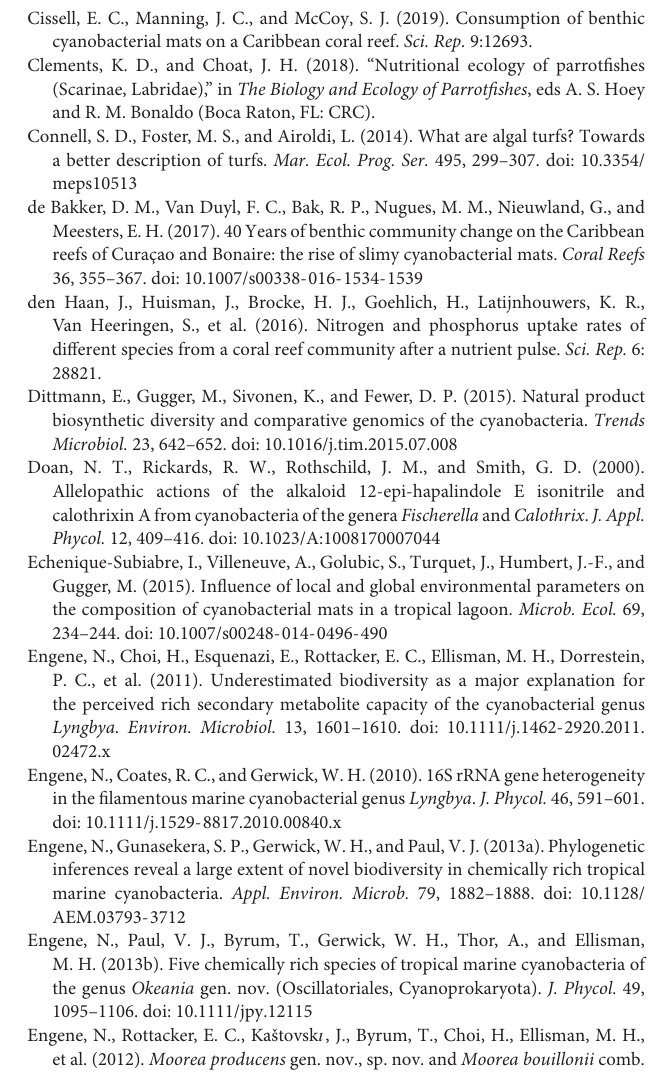
Supplementary Figure 1 | Concentration–response curves after 48 h of incubation of Artemia salina nauplii exposed to cell-free filtrates of PAB BCM . Response expressed as average% mortality in each exposure concentration. LC 50 -48 h is shown for the three samples where this end point was calculable by the Trimmed Spearman–Karber method. The other samples have LC 50 -48 h higher than the highest exposure concentration. Whiskers: standard error. Supplementary Table 1 | Summary of ANOVA type II results for comparisons between incubation treatments and Tukey’s HSD post hoc test to verify differences in Symbiodinium growth index µ (d-1), between treatments and respective controls (without